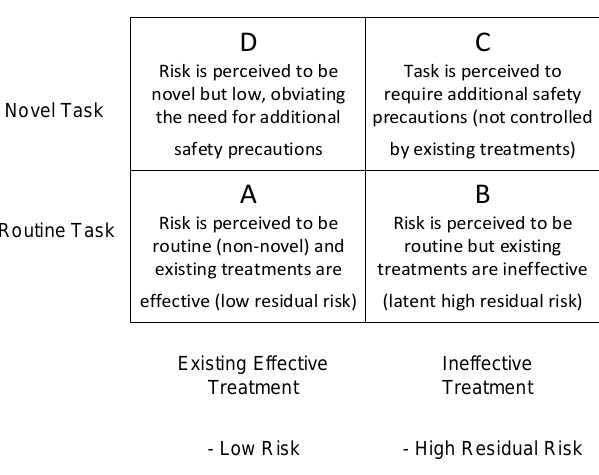
Figure 2. The Worker Evaluates Risky Task Model.